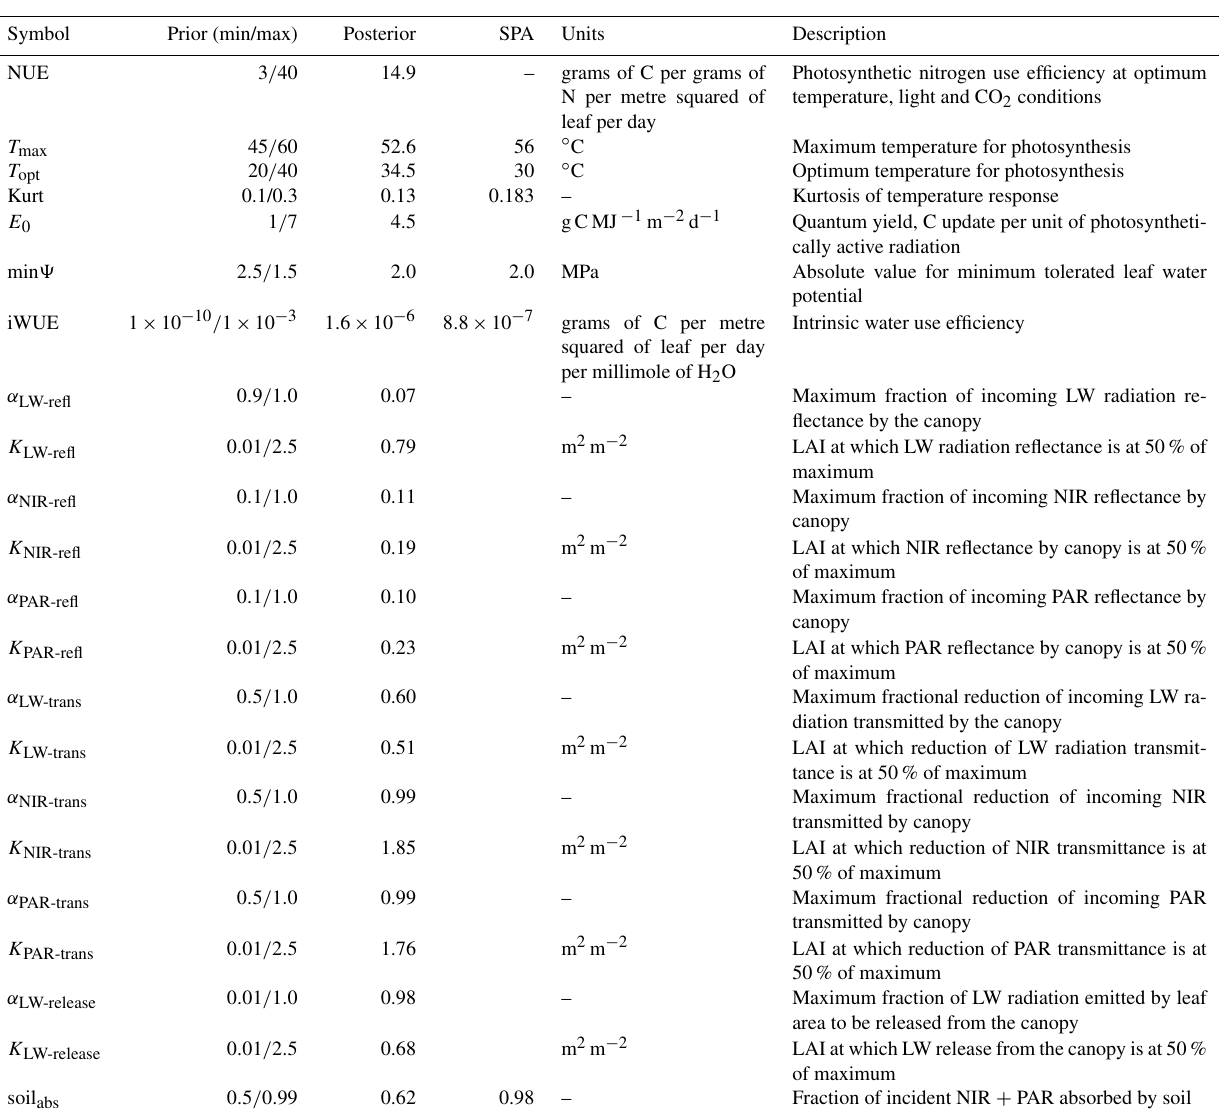
Table 2. ACM-GPP-ET parameters retrieved using the CARDAMOM model–data fusion system. For each parameter its symbol as used in the code description is given, along with the maximum and minimum values used for the prior ranges, the maximum likelihood estimate retrieved from the posterior distributions, units and a brief description. The SPA column contains the SPA parameter value used in the calibration where a direct equivalent is available. Near-infrared radiation is abbreviated as NIR, photosynthetically active radiation as PAR and long-wave radiation as